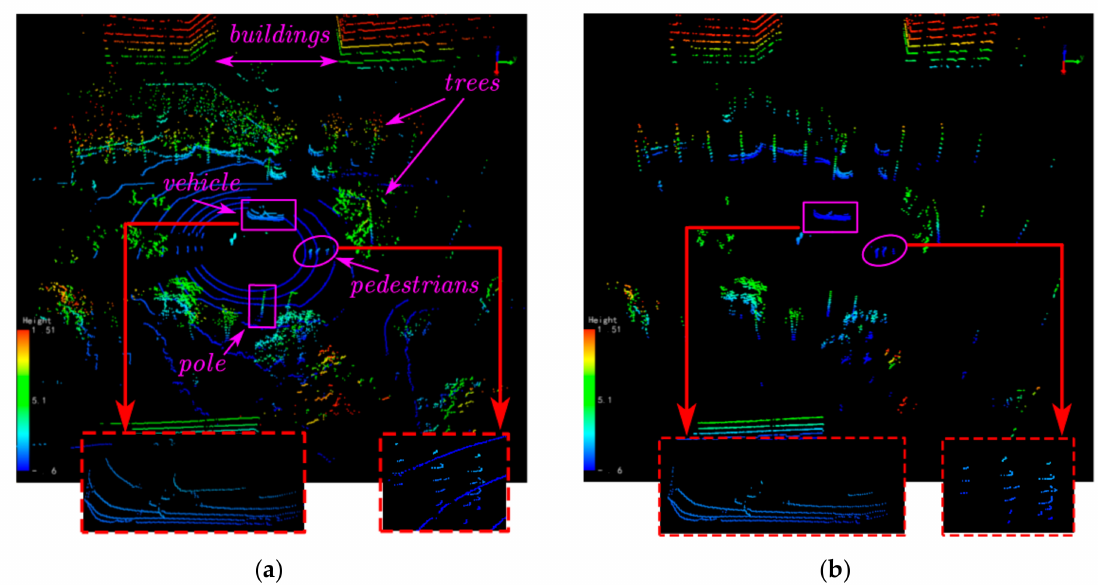
Figure 3. All points and all slices in a raw point cloud. ( a ) The points in a point cloud; ( b ) The points that belong to